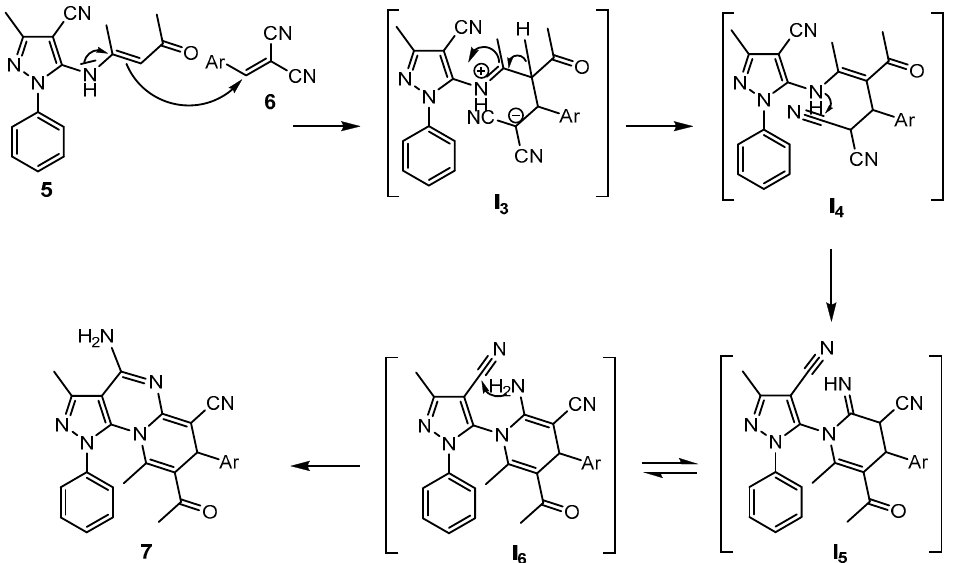
Scheme 4. Putative mechanistic pathway for the synthesis of target compounds 7a – l . Table 1. Cytotoxicity of compounds 3 , 5 , 7a – l against the human cancer cell lines A375, HT29, MCF-7, A2780, FaDu and non-malignant cells NIH 3T3 and HEK293 (n.d., not determined;n.s., not soluble under the conditions of the